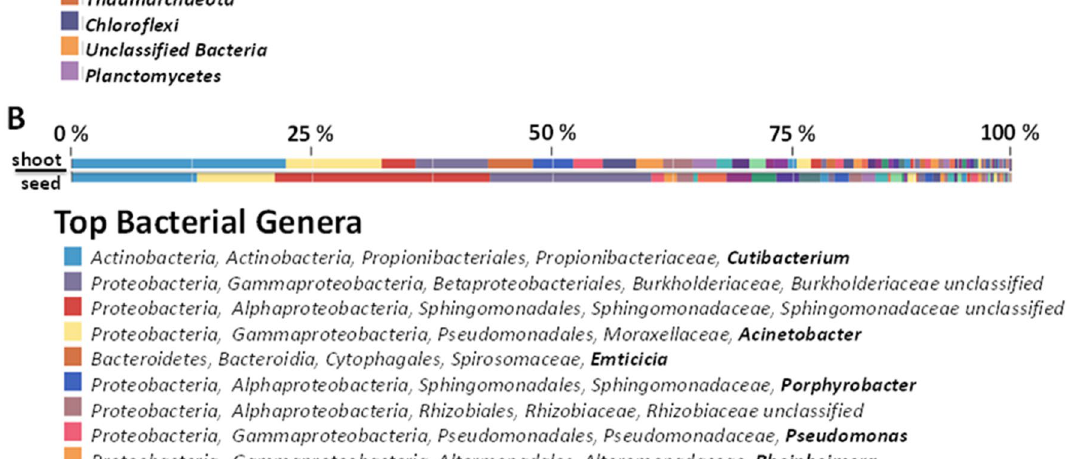
Figure 2. Relative quantification of bacterial phyla ( A ) and genera ( B ) of C. limon seed and shoot microbiota, as detected by NGS sequencing. In panel B, bacterial genera are highlighted in bold.